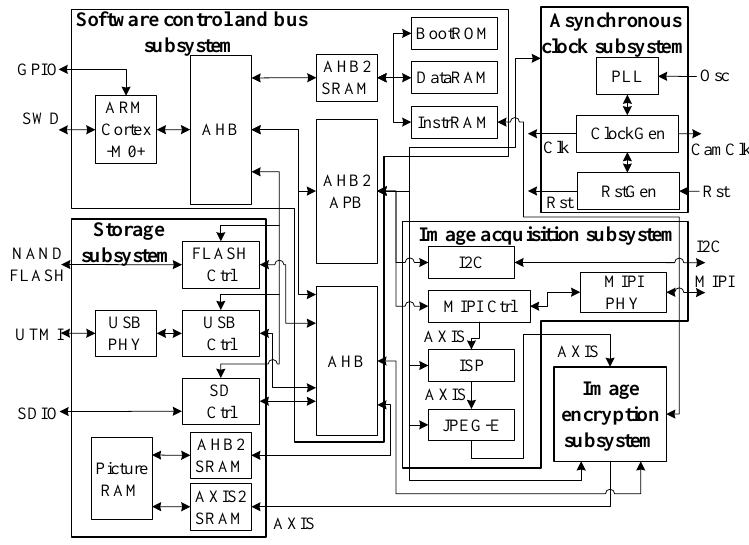
Figure 22. SoC detailed structure.